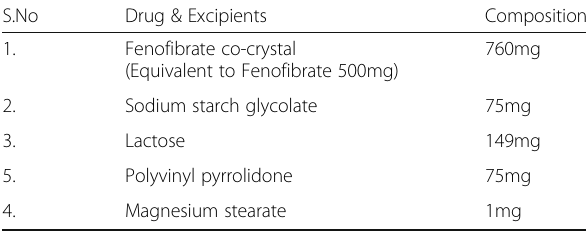
Table 7 The composition of prepared solid unit dosage form S.No Drug & Excipients